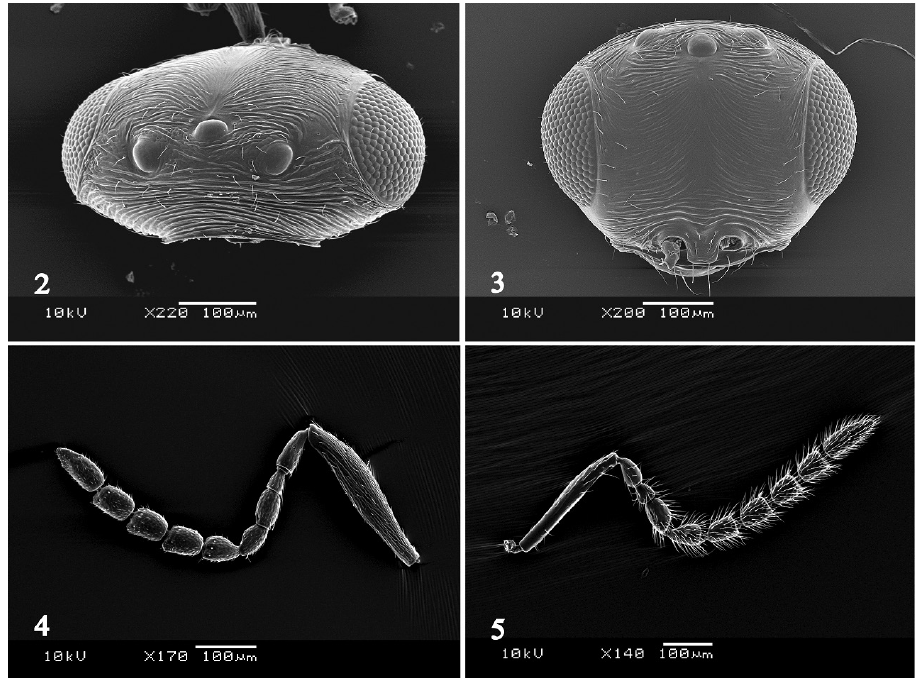
Figure 2–5. Platygaster ingeniosus . 2 female head, dorsal view 3 female head, frontal view 4 female an- tenna 5 male